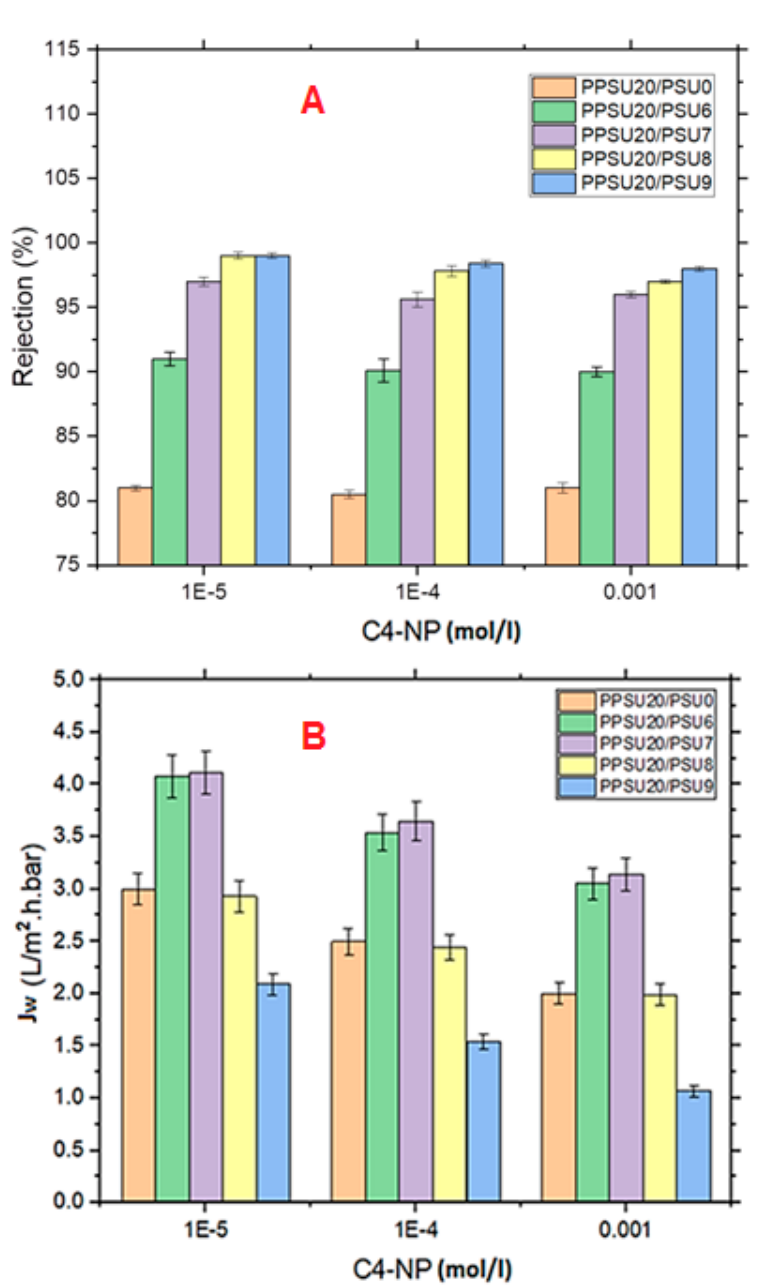
Figure 9. Rejection ( A ) and permeation ( B ) of 4 ‐ NP at different feed concentrations (pH 14, 25 °C and 3 bar).